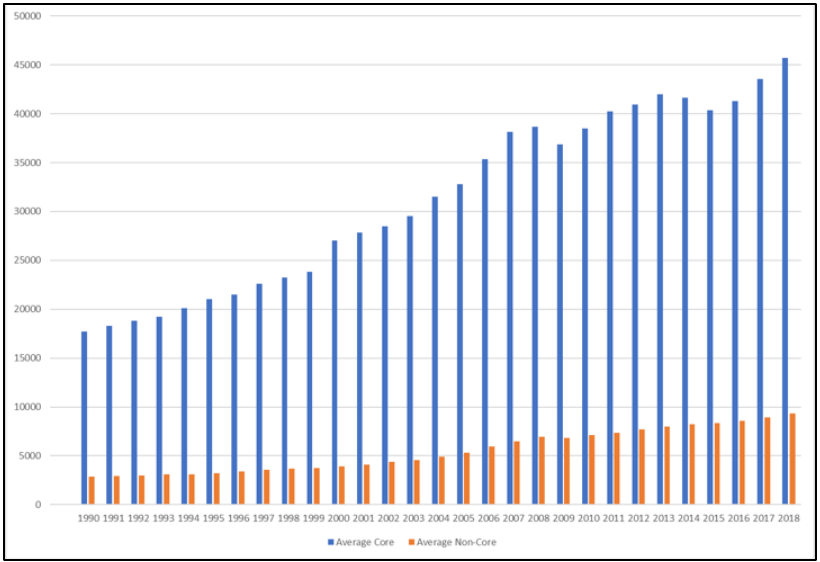
Figure 2: GDP per Capita Growth in Core versus non-Core Nations